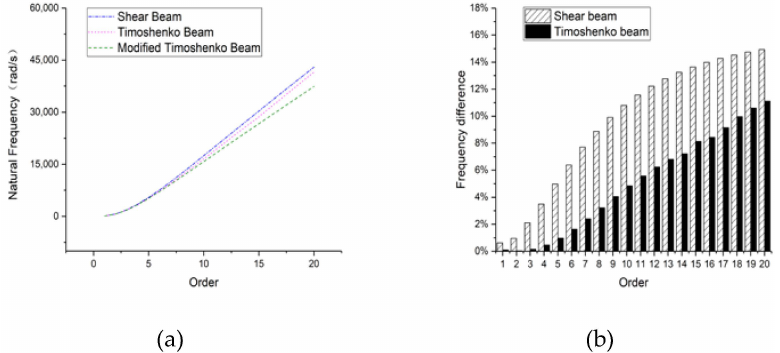
Figure 28. Natural frequencies of the 8-m-long beam: ( a ) overall frequency curve and ( b ) frequency di ff erence compared with a modified Timoshenko beam.